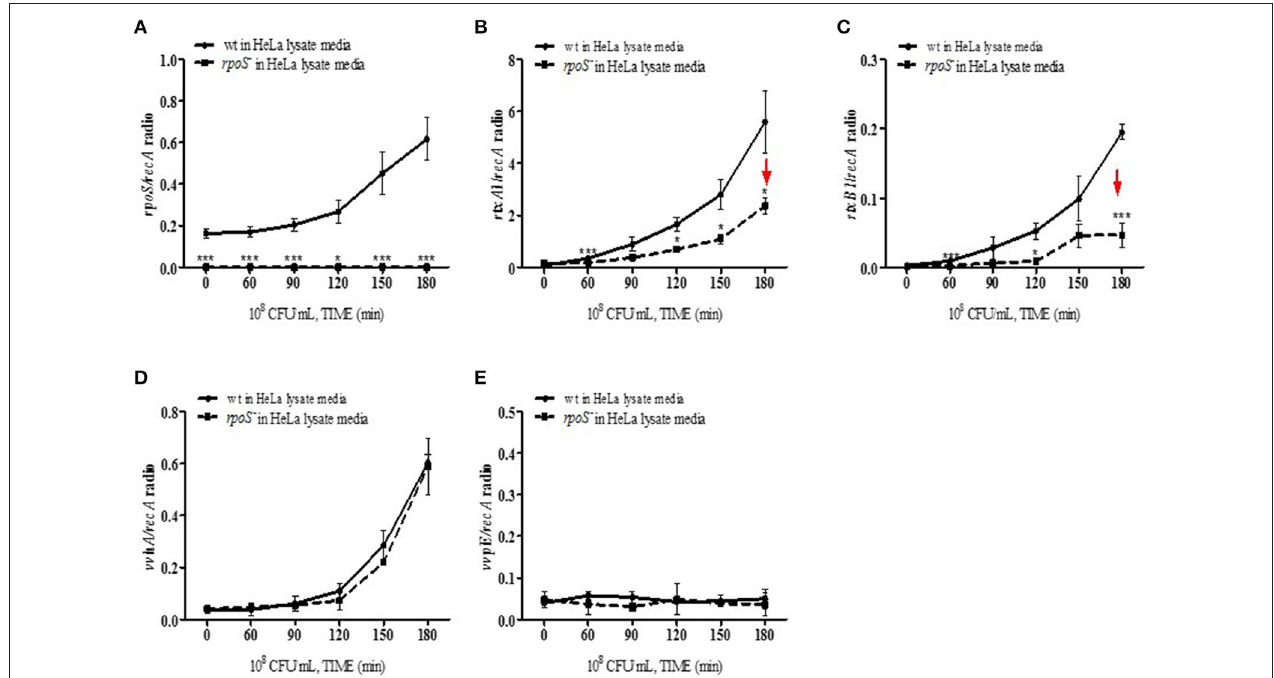
FIGURE 5 | Transcriptions of cytotoxic genes in HeLa lysate media were regulated by an rpoS mutation. V. vulnificus wild-type or an rpoS mutant strains was inoculated into the HeLa lysate media, and the transcriptional activities of genes rpoS (A) , rtxA1 (B) , rtxB1 (C) , vvhA (D) , and vvpE (E) in each strains were separately estimated by qPCR. Results represent the average of at least three independent experiments. Values are means ± SD (vs. V. vulnificus wild-type, * P < 0.05, ** P < 0.01, *** P < 0.001).